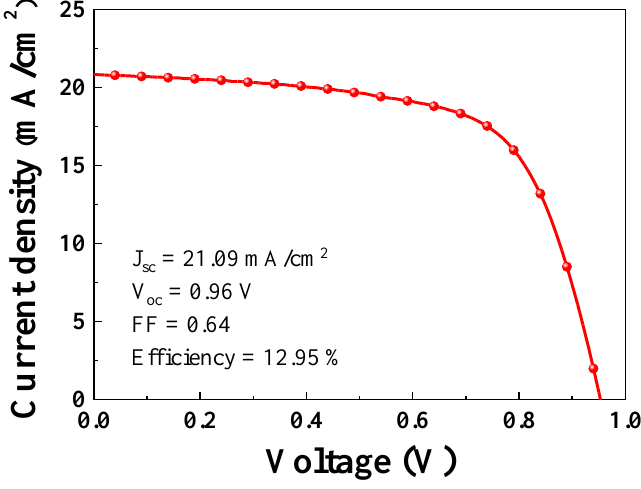
Figure 6. J-V curve of the single PSC.